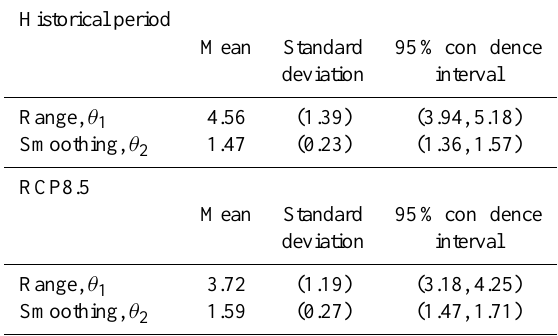
Table 2. Multi-model ensemble means of range and smoothing pa- rameter estimates, standard deviations, and 95% confidence inter- vals for parameters from modeling of Brown–Resnick processes. Range parameter estimates decrease under the future RCP8.5 sce-